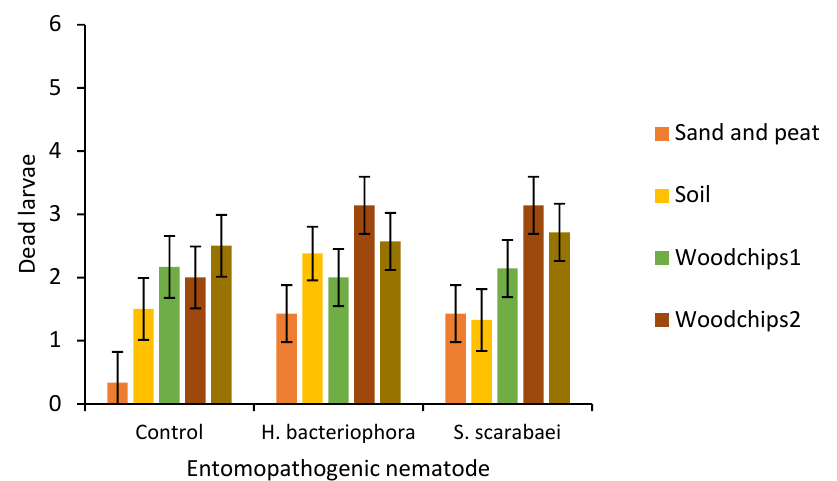
Figure 3. Number of dead Popillia japonica larvae (mean ± SEM) 20 days after placing six third-instars per outdoor microplot (30 × 30 × 30 cm) that was partially filled with either sand and peat, field soil, woodchip types 1 or 2, or municipal compost and woodchips type 1 and inoculated with the entomopathogenic nematodes Heterorhabditis bacteriophora or Steinernema scarabaei (50 infective juveniles/cm 2 ). Galvanized steel microplots were placed in the soil in Agriculture and Agri-Food Canada research plots near Jordan Station, ON, Canada.